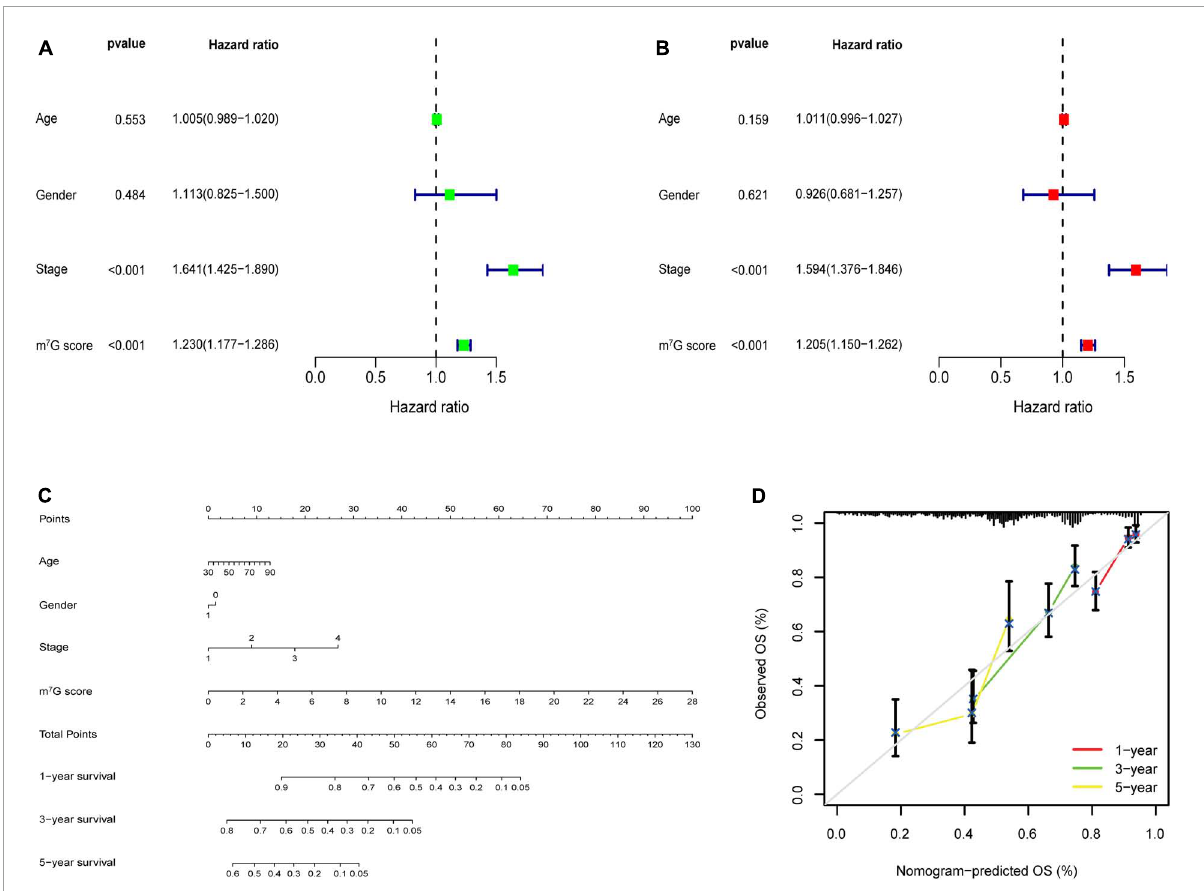
FIGURE9 m 7 G related signature analysis and nomogram construction. (A) Univariate analysis of m 7 G score and clinical factors. (B) Multivariate analysis of m 7 G score and clinical factors. (C) Establishment of nomogram. (D) Calibration curve of the